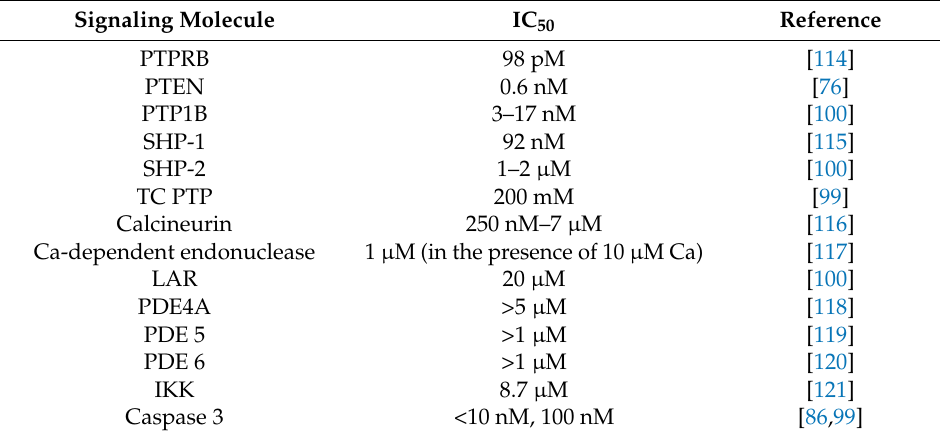
Table 2. IC 50 values for signaling molecules in